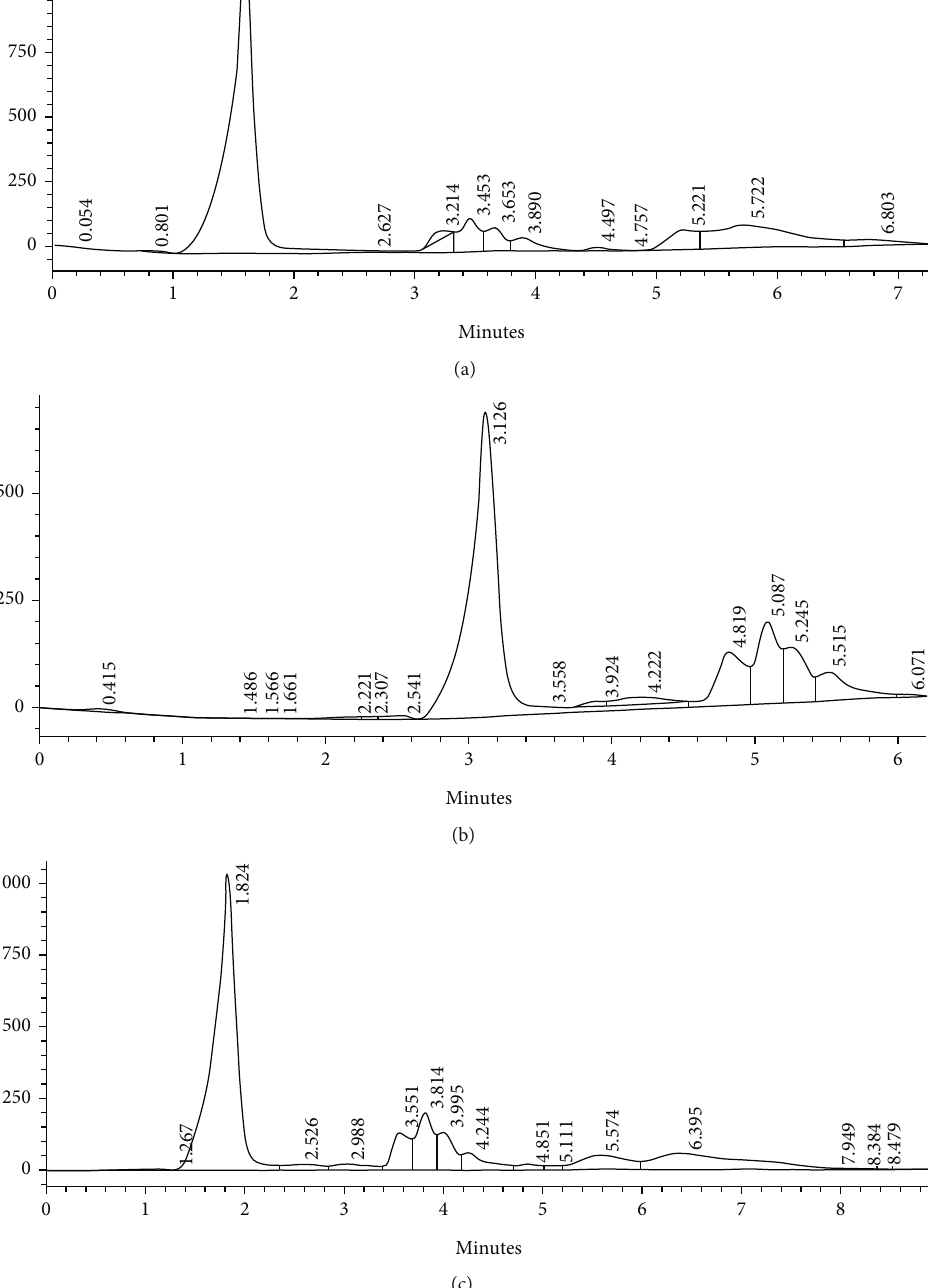
and D in fresh mushroom: (a) not exposed, (b) exposed to sunlight 2 3